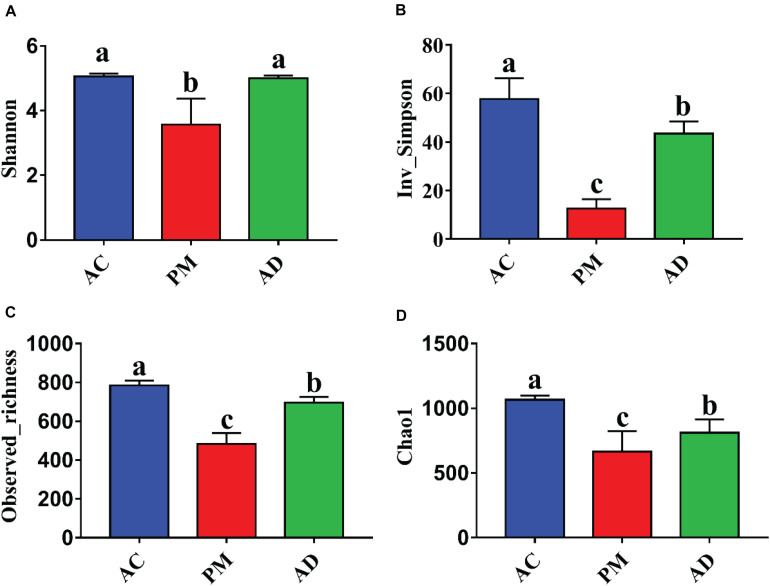
(A) The shannon index. (B) The Inv_Simpson index. (C) The observed_richness index. (D) The Chao index. Summary of α diversity indices. PM, swine manure samples; AC, aerobic composting samples; AD, anaerobic digestion samples. The error bar indicates standard error.